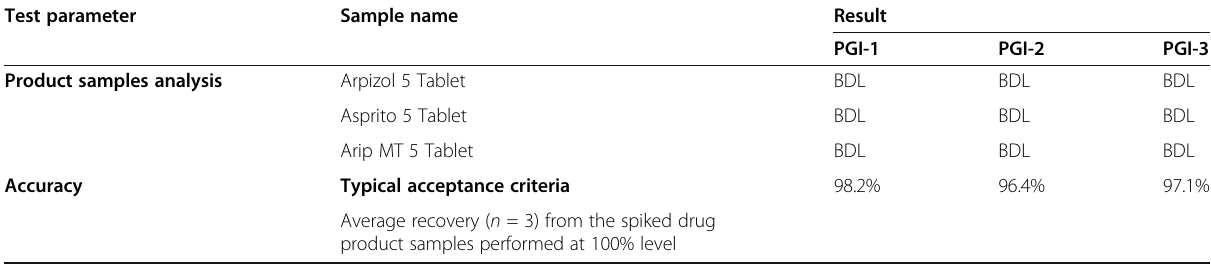
Table 3 Summary of drug product application results Test